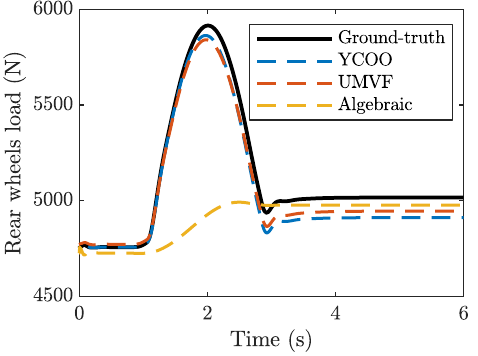
Figure 7. Vertical tire force estimation when driving on a 20%